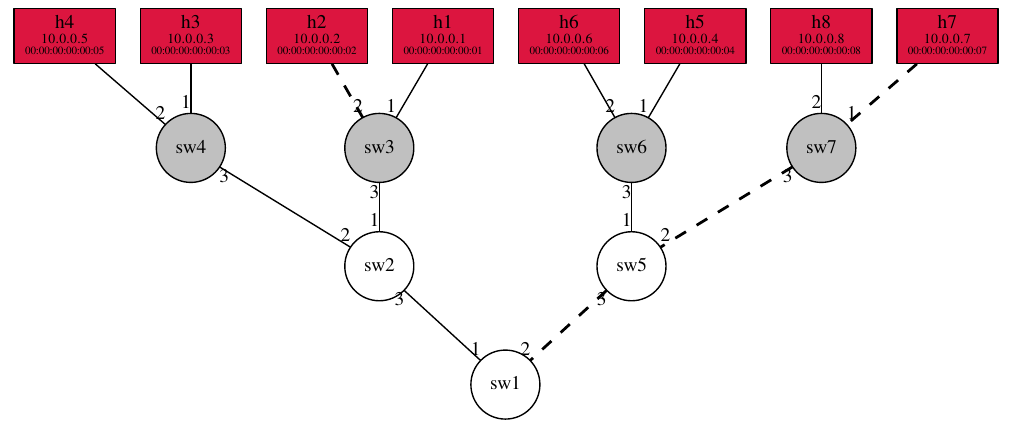
Figure 10. Failing links (marked with dashed lines) on a sample network as the framework displays it at the end of failure